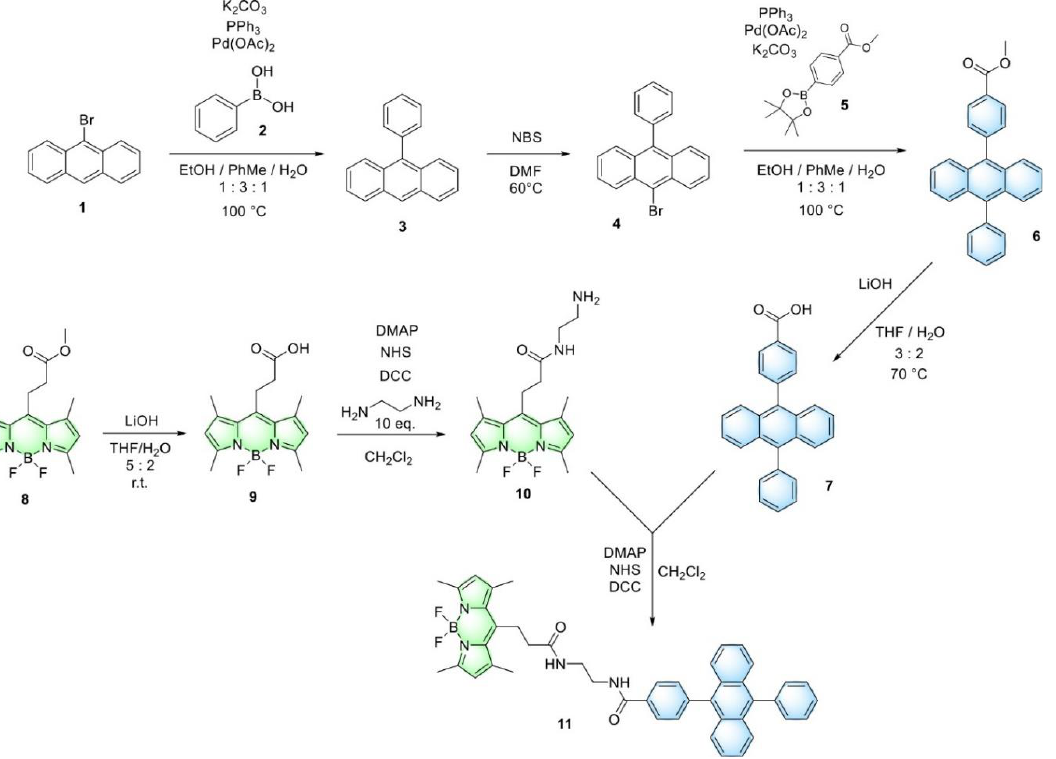
Scheme 1. Synthesis of BODIPY-DPA dyad 11 .